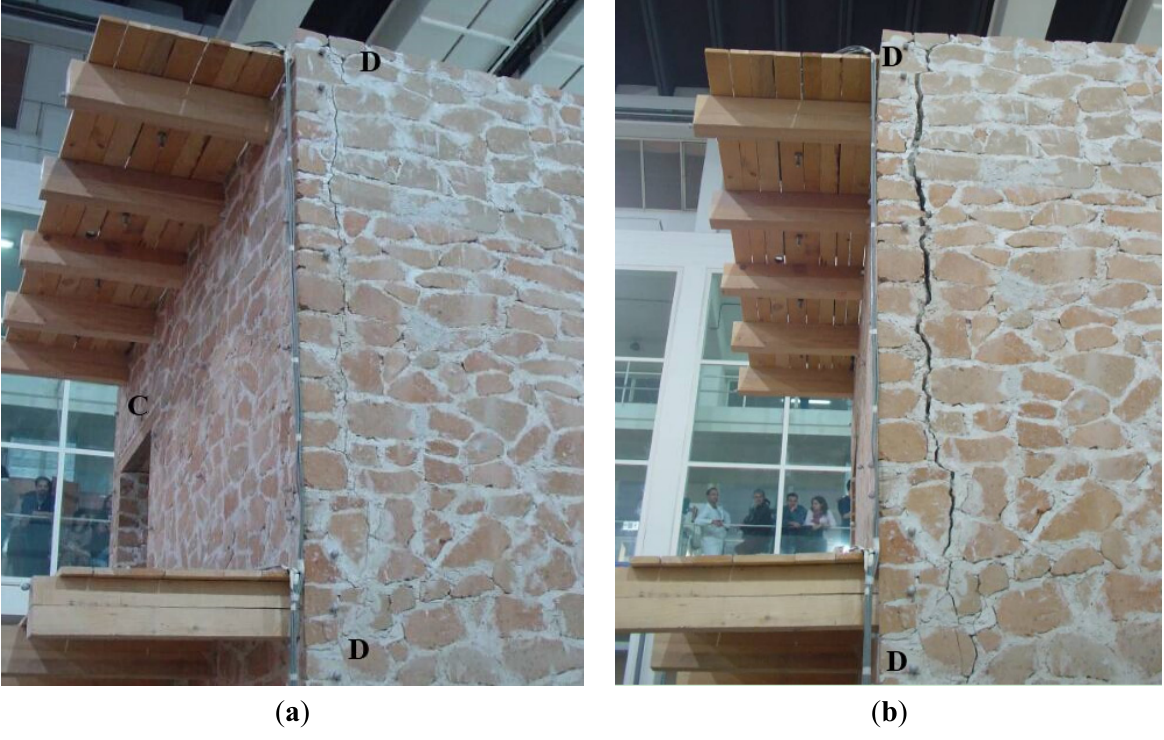
Figure 5. Vertical crack in the corner between the façades AD and CD after the tests with nominal PGA of ( a ) 0.15 g and ( b ) 0.25